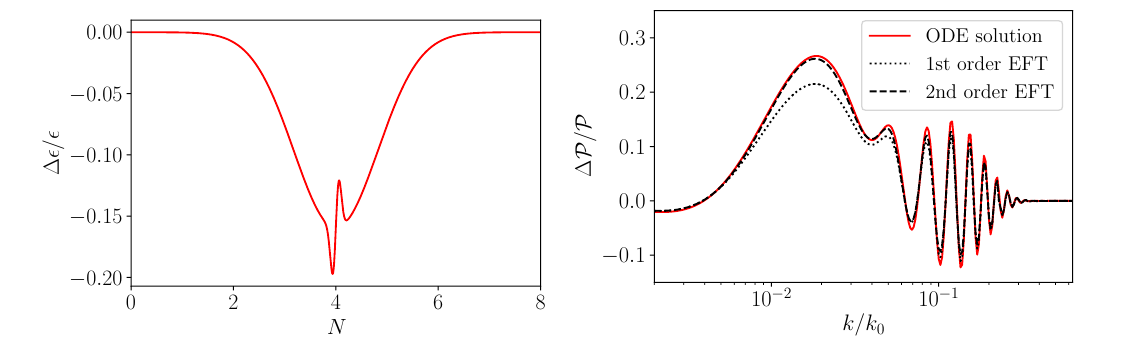
Figure 1: Red line: fractional change Figure 2: The dotted / dashed lines ∆ ε/ε (21) with parameters c = − 0.159, are the power spectra obtained via the 1 = 0.99, σ = 1.16, σ = 0.09 and c 1st / 1st + 2nd-order expressions (14) and 2 1 2 (18) respectively. The red line is the nu- merical result.